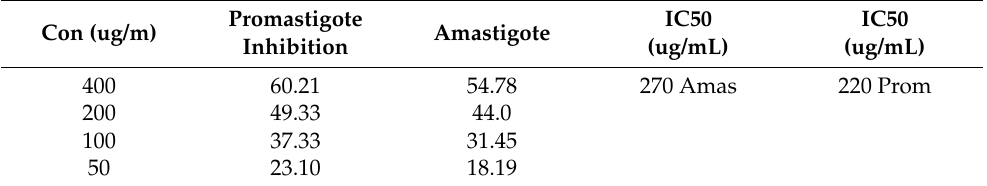
Table 5. Percent mortality of amastigote and promastigote parasites, in vitro cholinesterase potential of the ZnO